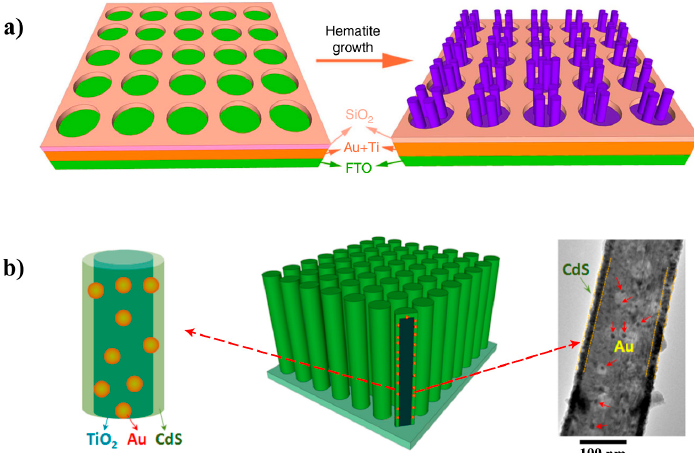
Figure 4. Schematic diagram for the architecture design of ( a ) the growth of the hematite nanorod array on the Au nanohole array and ( b ) CdS-Au-TiO 2 sandwich nanorod array. ( a ) Reproduced with